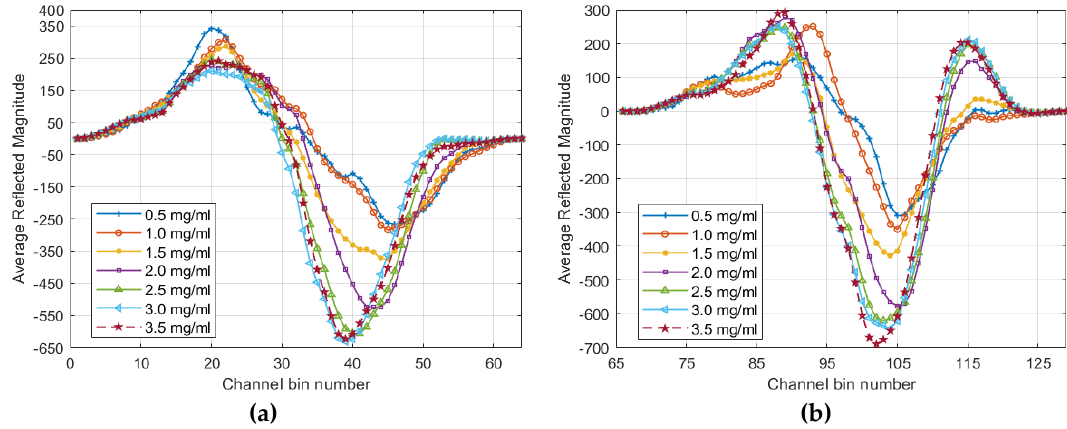
Figure 9. Average raw data in the three trials for each concentration across each radar channel: ( a ) channel 1; ( b ) channel 2.